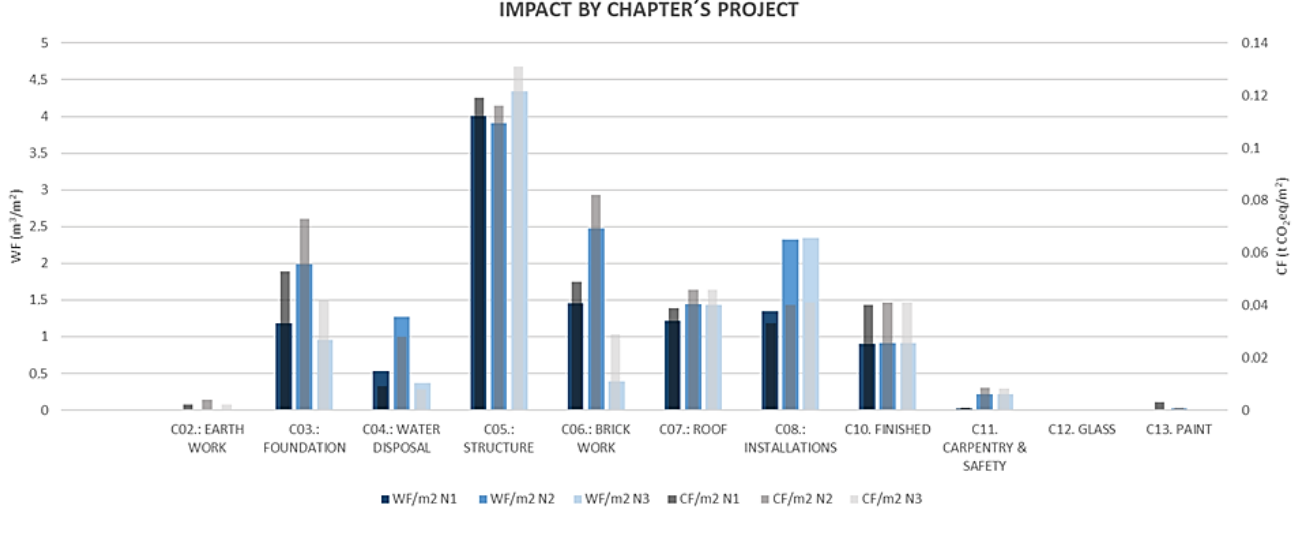
Figure 6. Carbon and water footprint of case studies per chapter of the classification system.